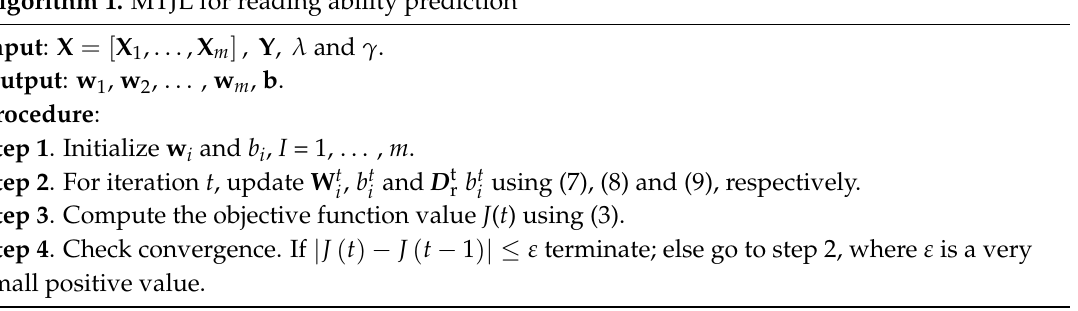
Algorithm 1. MTJL for reading ability